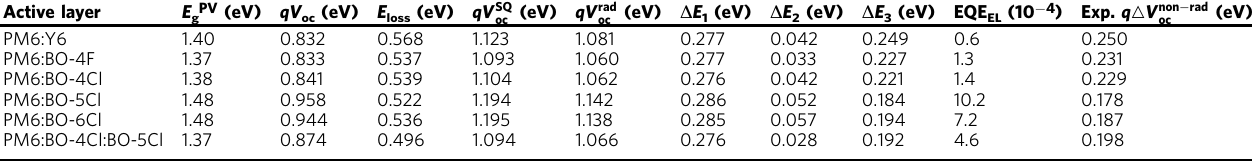
Table 2 Detailed energy losses in devices based on different acceptors. Active